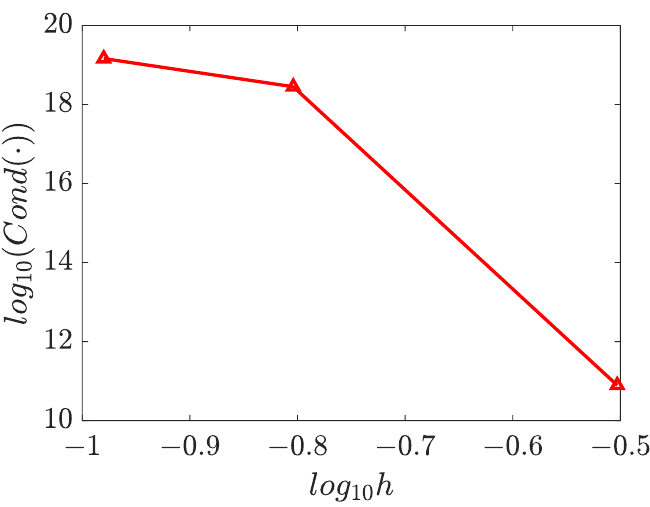
Figure 19. Convergence of wave number for the 2D varying parameter identification problem.